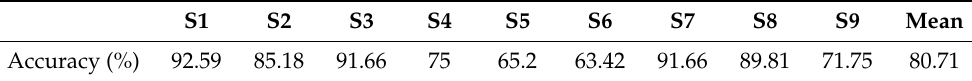
Table 2. The classification accuracy for each subject (Si) of the IIa data